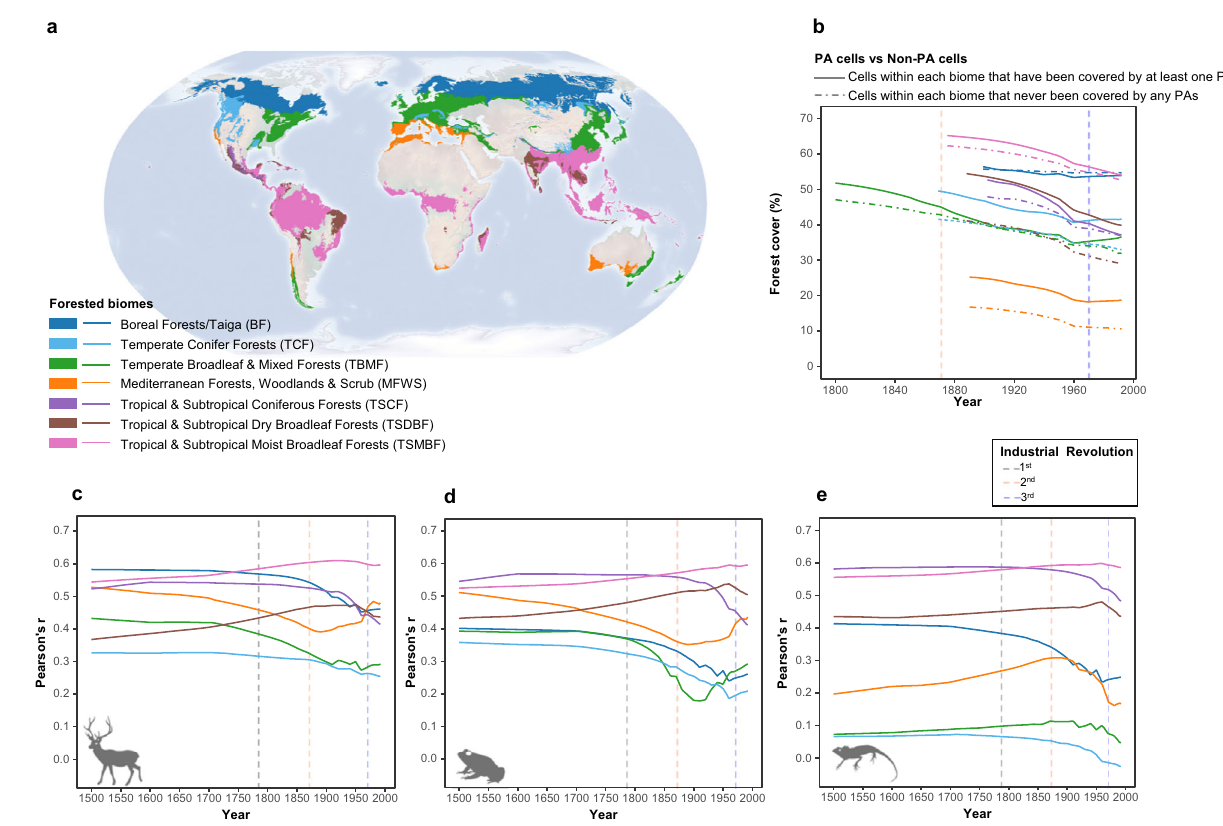
Fig. 3 Evidence of vertebrate extinction debts at the regional scale over seven forested biomes. The distributions of the seven forested biomes a . Comparison of the forest cover changes between the cells that have been covered by at least one protected area and the cells that have never been covered by any PAs b . Annual change in correlation coef fi cients (Pearson ’ s r) between forest cover and all forest-dwelling mammal species richness c , all amphibian species richness d , and all reptile species richness e